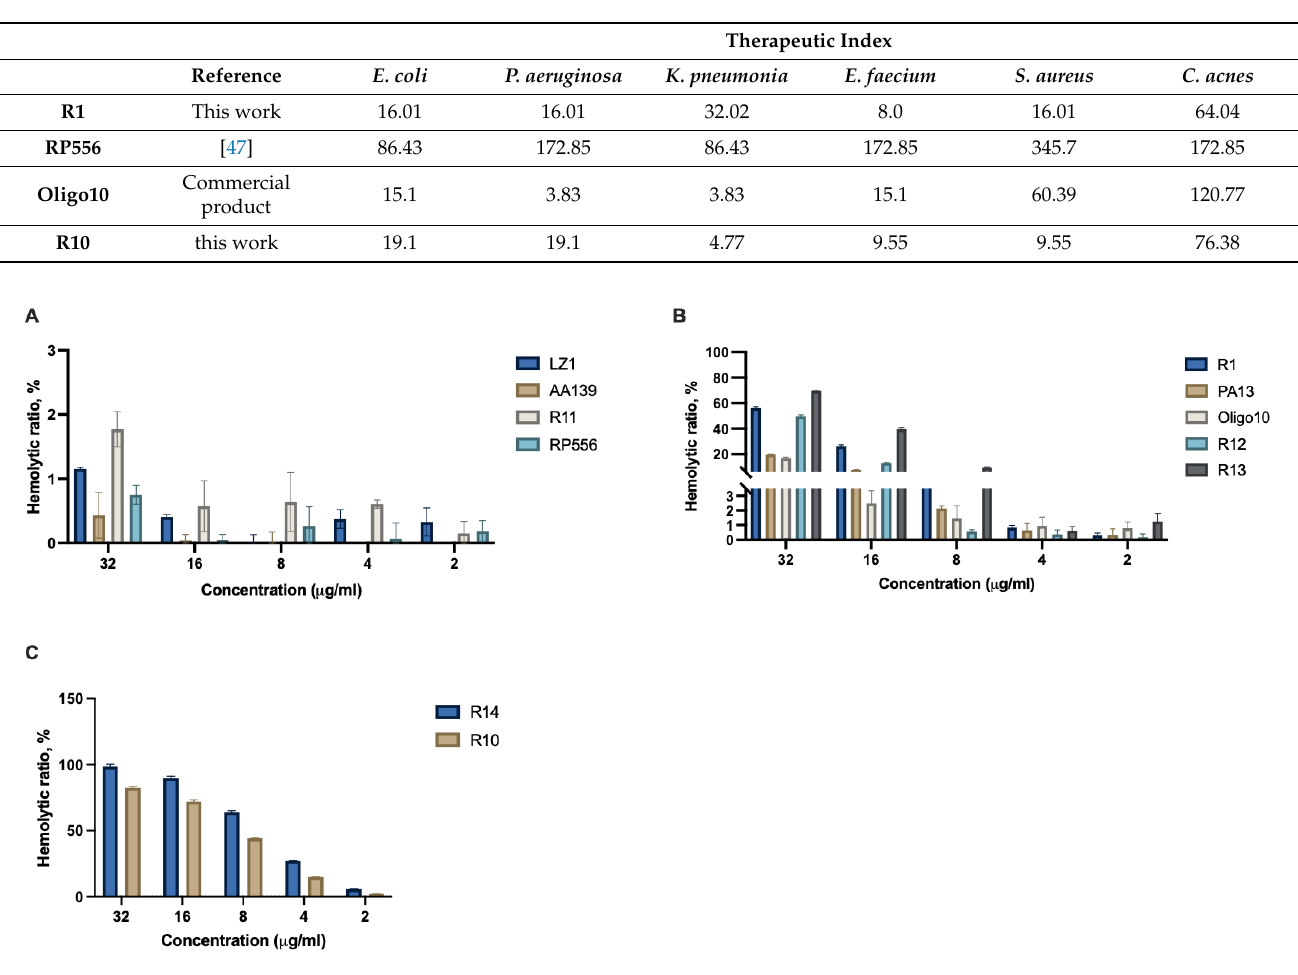
Table 4. Therapeutic indexes of antimicrobial peptides. Calculations done based on cytotoxicity (IC 50 ) in human primary dermal fibroblast cell line and MIC values against listed bacteria.